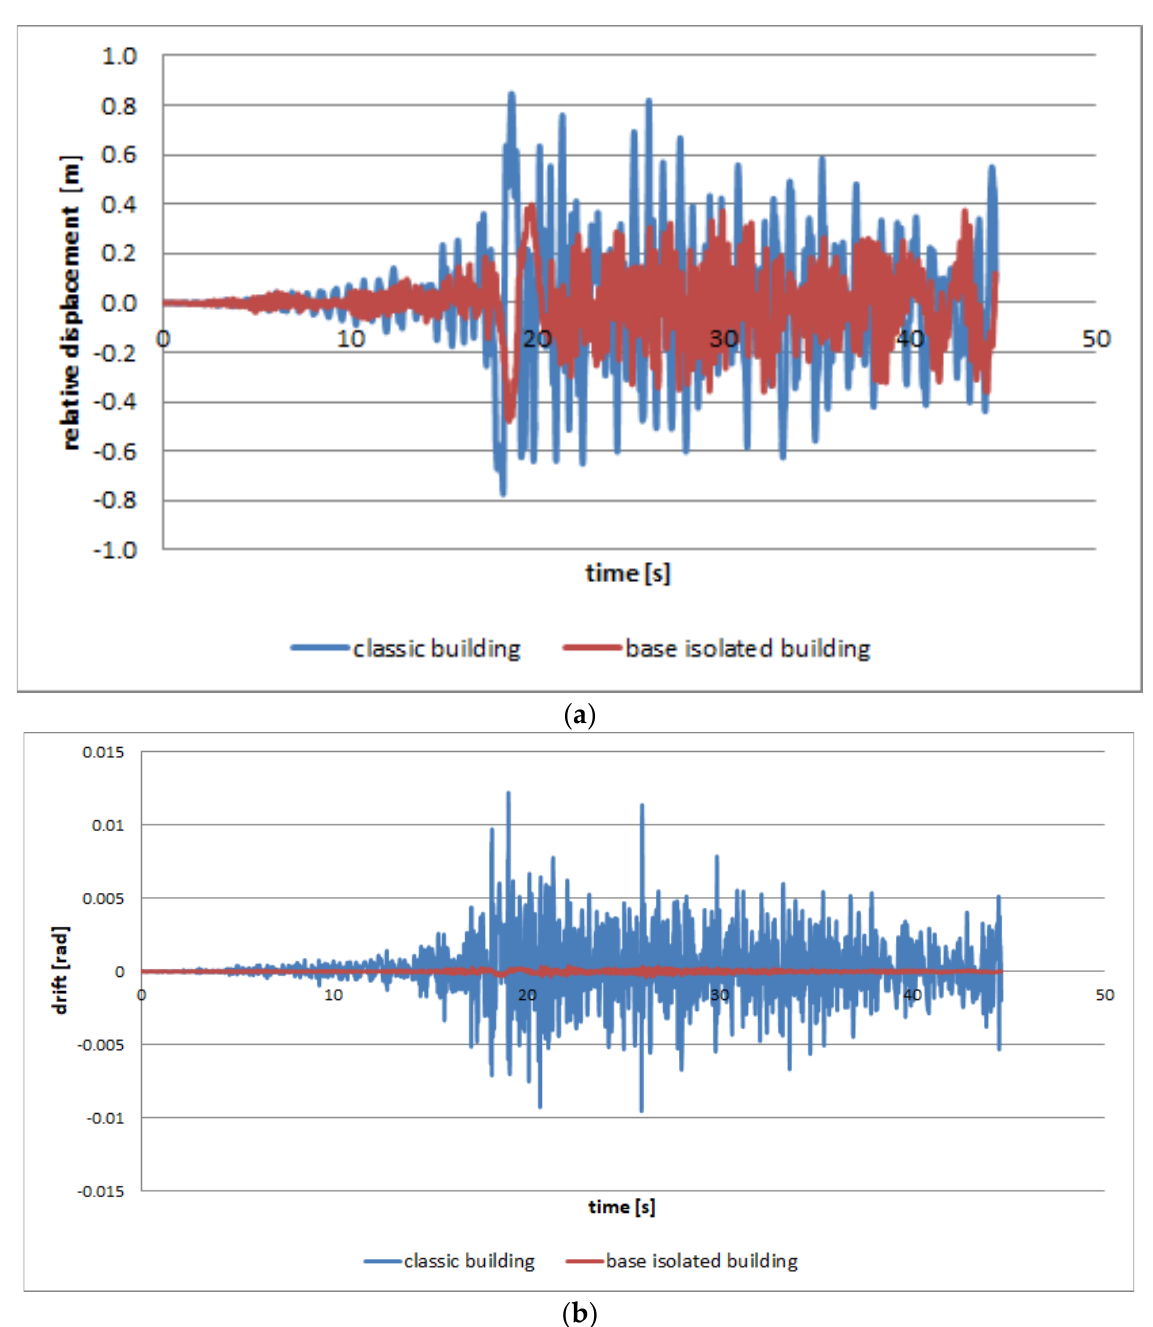
Figure 11. ( a ) Relative displacement [m] time histories at building top, INCERC 1977 spectrum compatible ground acceleration record; ( b ) drift time histories at level 1, INCERC 1977 spectrum compatible ground acceleration record.